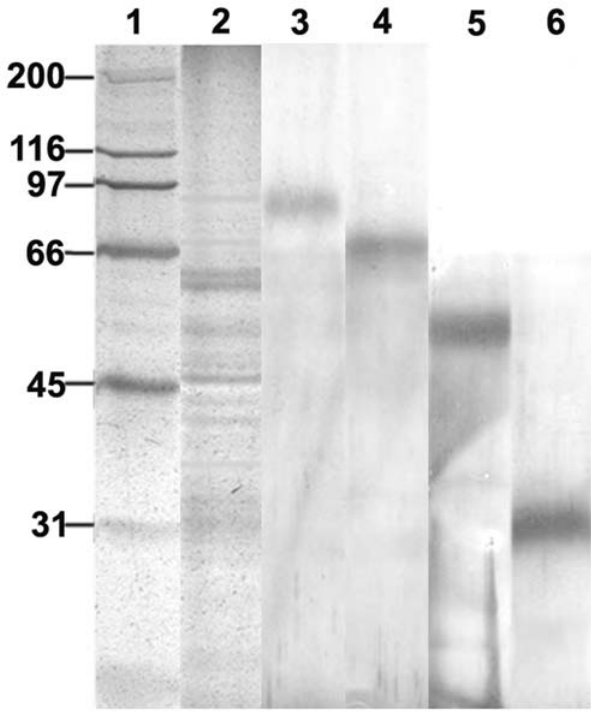
Figure 1. Silver-stained SDS-PAGE gel of Leishmanial antigens (LAg) and purified antigens by electroelution. Lane 1, molecular mass markers; lane 2, LAg ; lane 3, 91-kDa (LD91); lane 4, 72-kDa (LD72); lane 5, 51-kDa (LD51); lane 6, 31-kDa (LD31). The positions of molecular mass standards are shown on the left in kilodaltons.